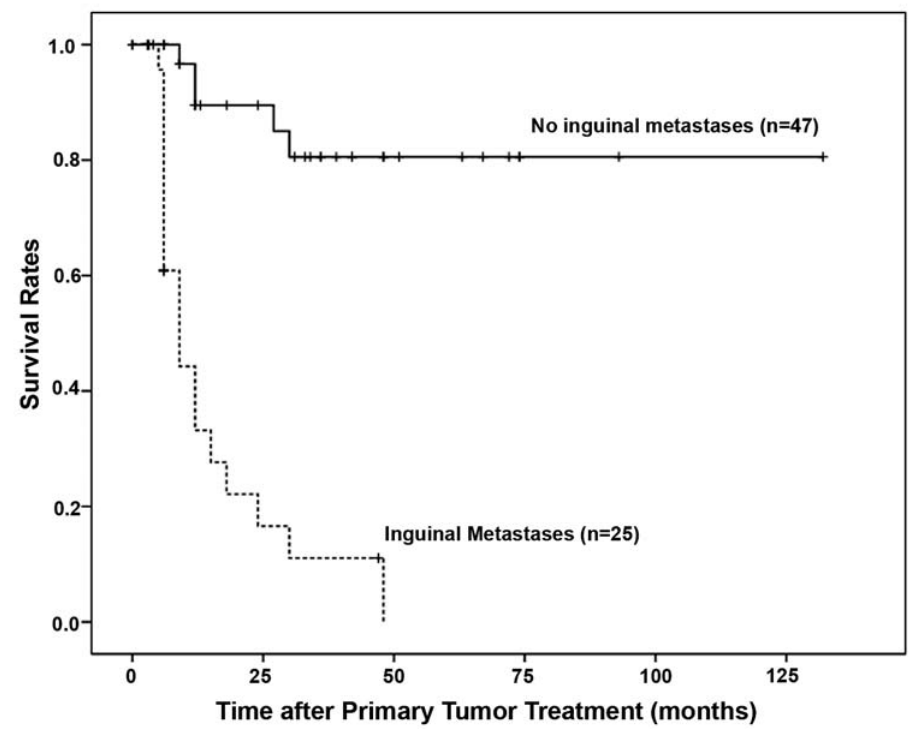
Figure 1 – Respective 10-year survival rates according to the presence (n = 25) or absence of inguinal metastases (n = 47). Kaplan- Meier method (p < 0.0001, log rank